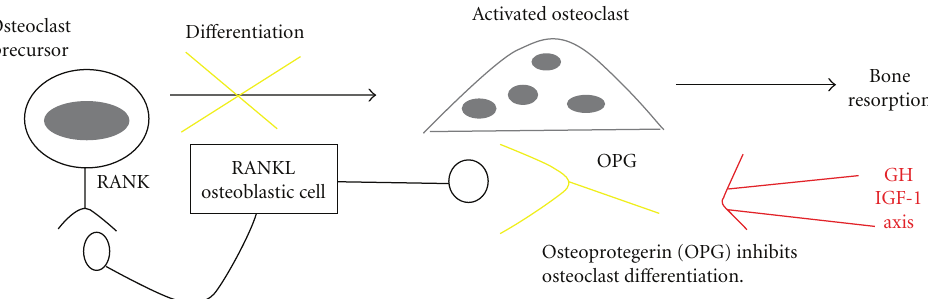
Figure 1: RANK-RANKL-osteoprotegerin mechanism of bone remodelation (adjusted by Lipincott Williams & Wilkins, South Med 2004). of administration. RhGH causes an increase in urinary and serum calcium after 3–6 months, an e ff ect